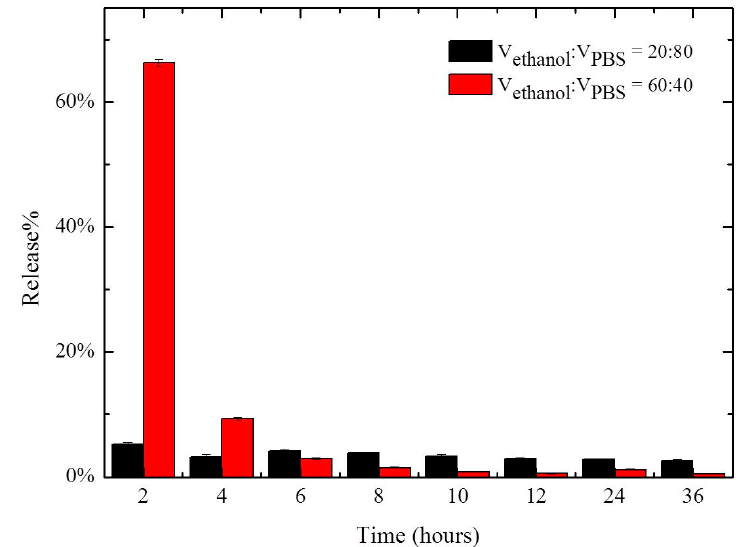
/ Gly / GA / Cur composite film versus